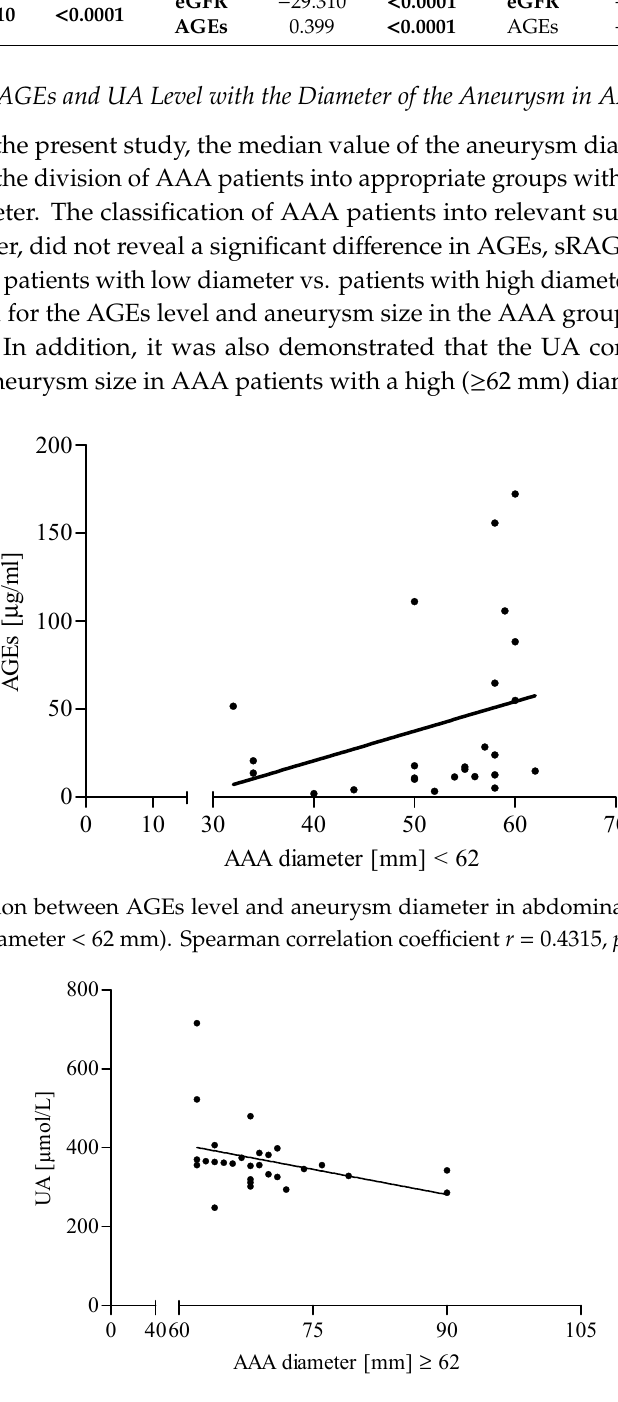
Figure 6. Correlation between uric acid (UA) concentration and aneurysm diameter in AAA patients (diameter ≥ 62 mm). Spearman correlation coe ffi cient r = − 0.4602, p = 0.0137.